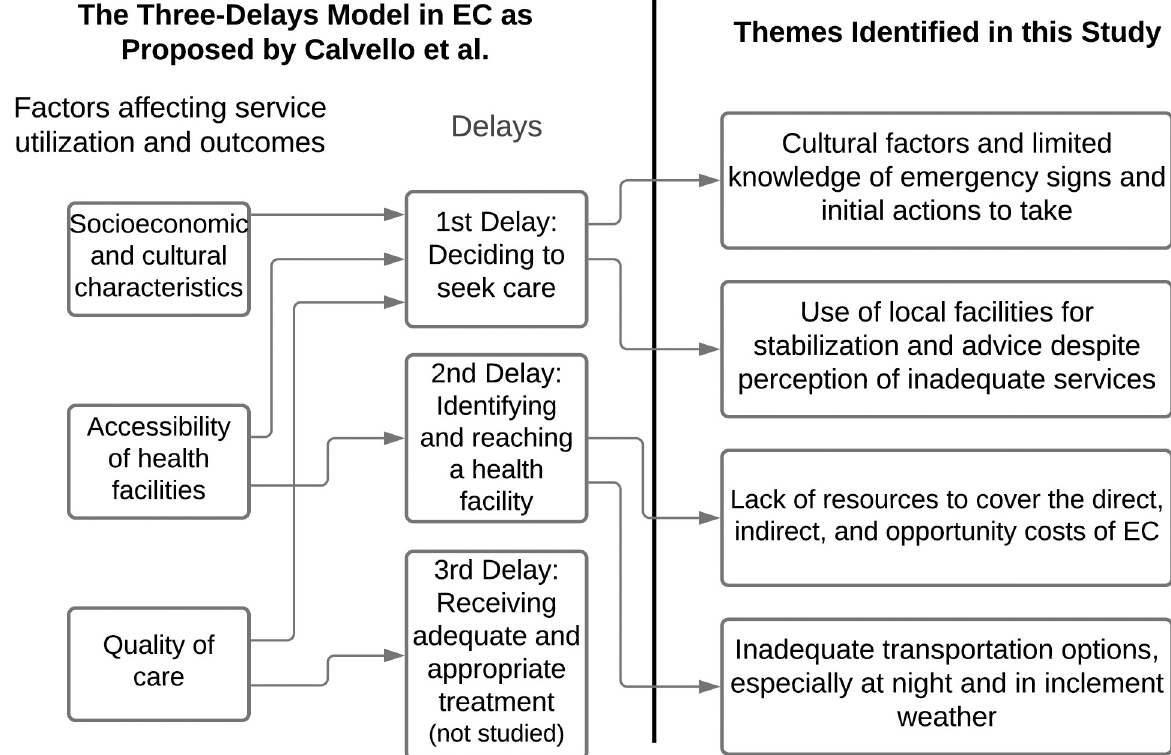
Fig 1. Themes of delay of this study correlated with the three delays model. Abbreviations: EC, emergency care.